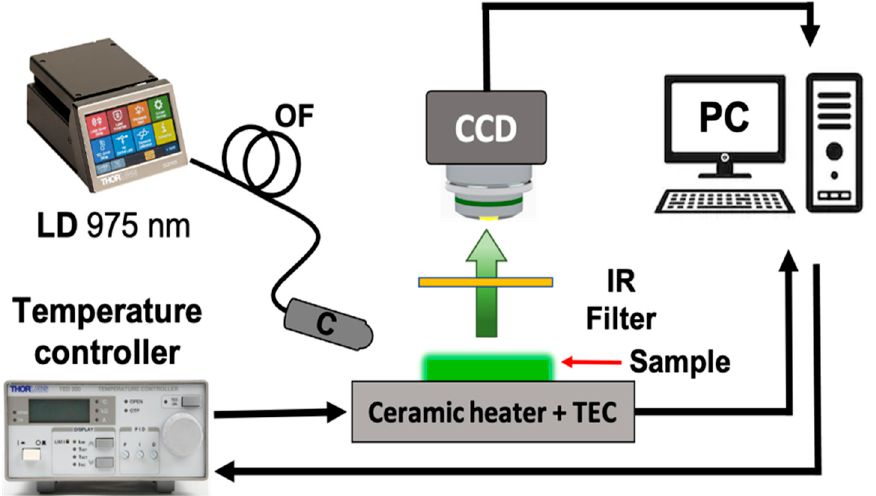
Figure 3. Schematic representation of the experimental setup used to analyze the fluorescence from the PDMS-YbEr membranes as a function of temperature: light from a laser diode (LD) coupled to an optical fiber (OF) is collimated (C) and used to irradiate the sample. The fluorescence from the membrane is captured by a CCD camera after filtering the residual IR radiation. Temperature adjustments are made by a TEC controller connected to a personal computer (PC), which is also for image acquisition.